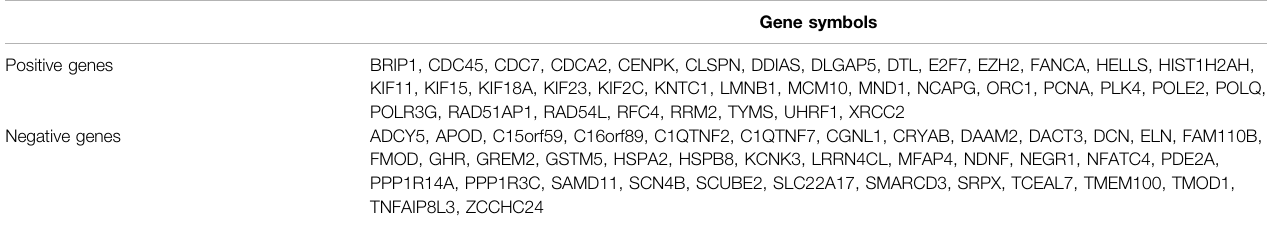
TABLE 2 | Positive and negative genes used in the HR-LR model and Cancer-Normal model.